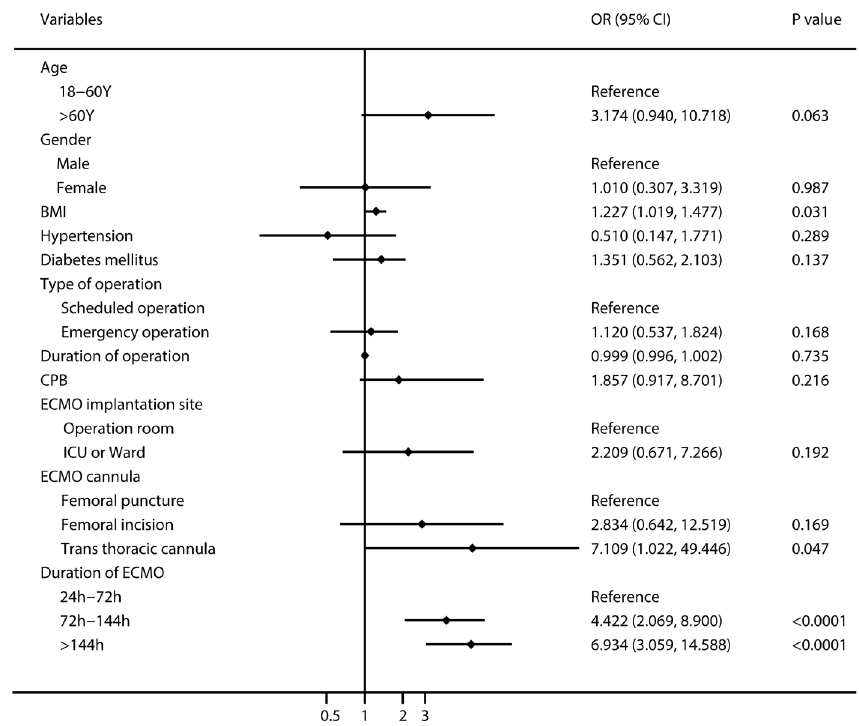
Fig. 4 - The multivariate logistic regression analysis of risk factors for extracorporeal membrane oxygenation (ECMO)-related blood stream infection. BMI=body mass index; CI=confidence interval; CPB=cardiopulmonary bypass; ICU=intensive care unit; OR=odds